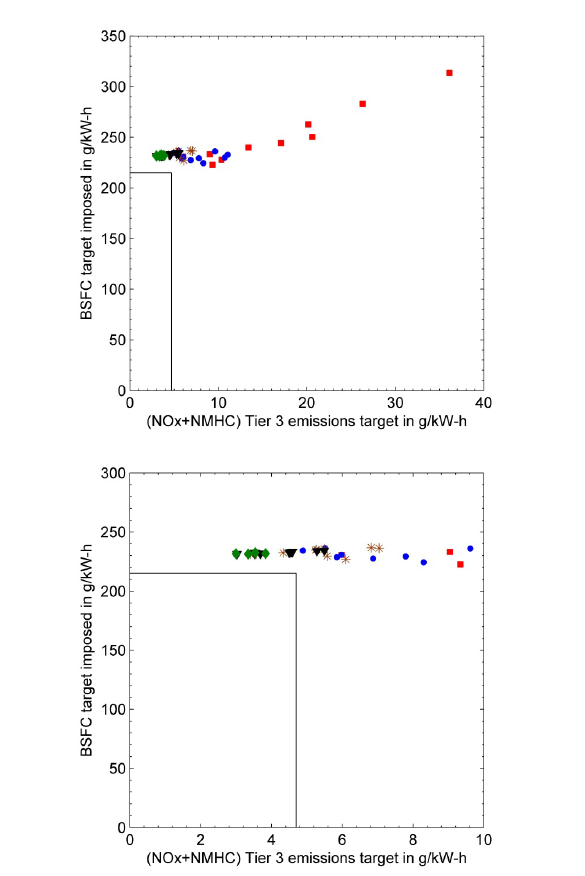
Fig. 11: Comparison of optimization results against the Tier 3 emis- sions targets